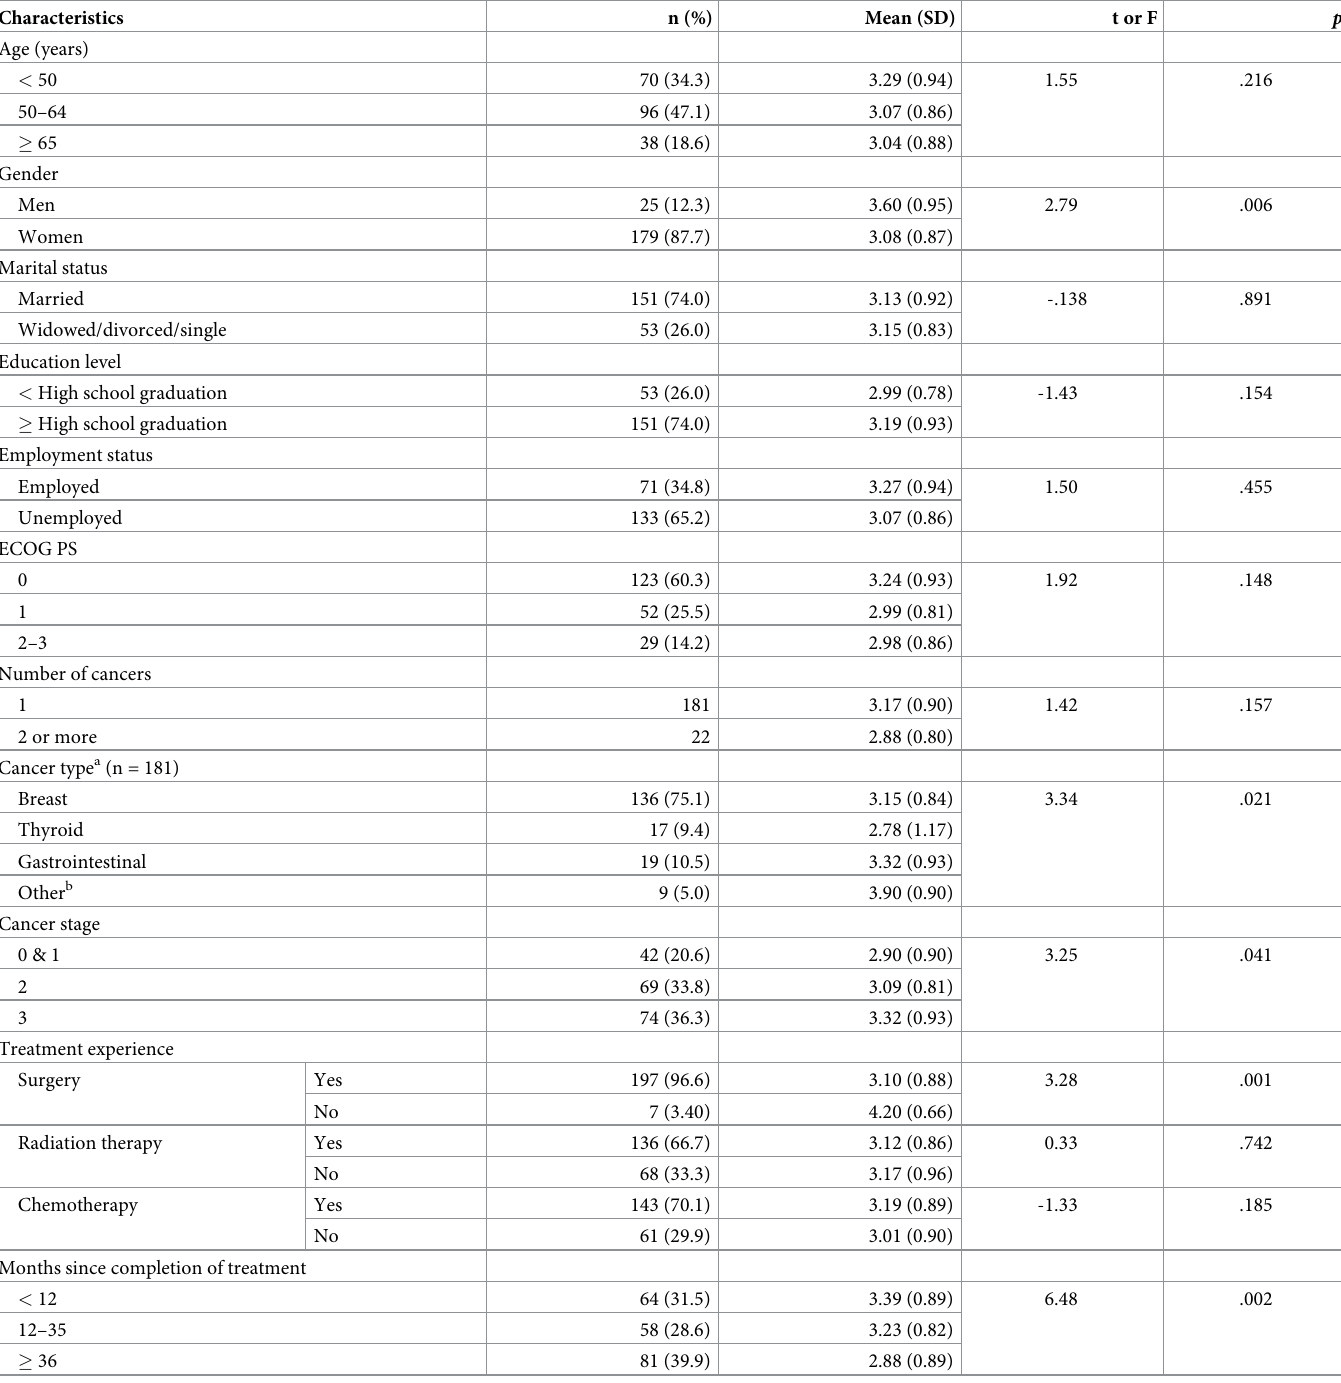
Table 1. Participant characteristics and the K-PACIC-CS scores.